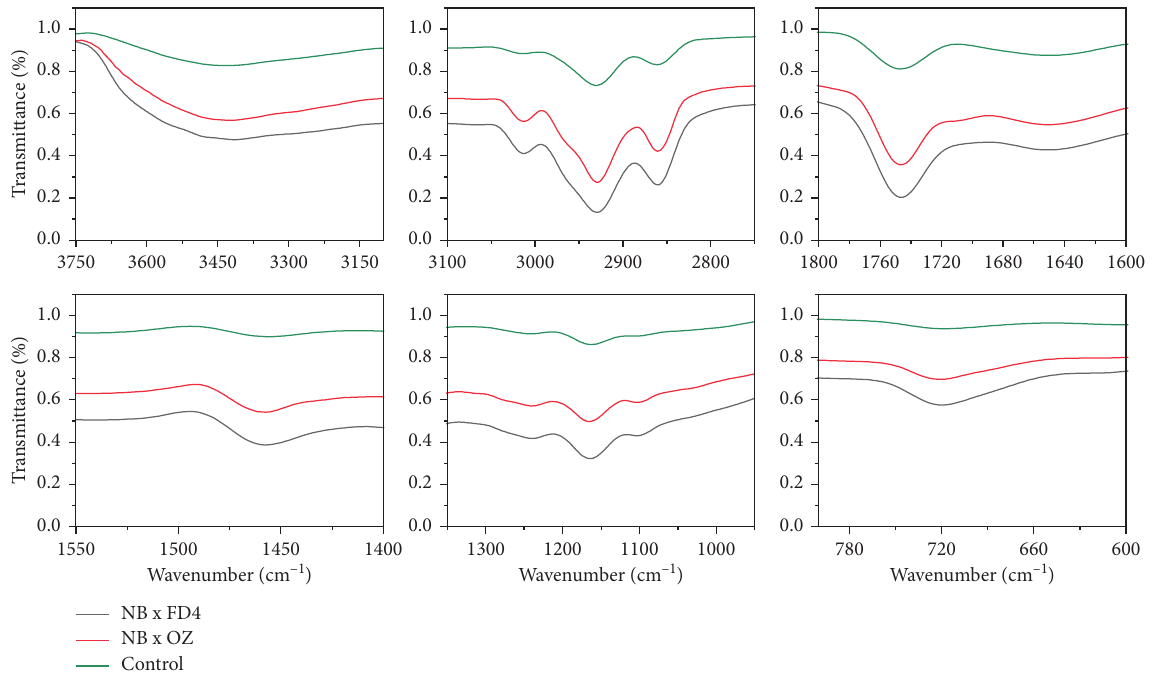
Figure 5: Major vibrational regions of fig seeds ATR-FTIR spectrum as affected by pollination. FD4:Frond d’Oued N ° 4; OZ :